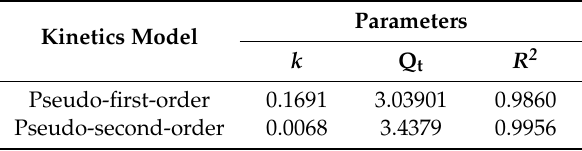
Table 1. Kinetic adsorption models constants of